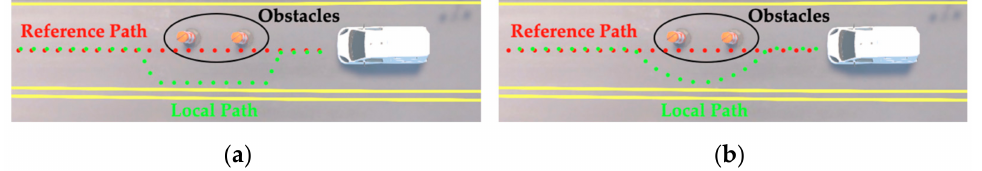
Figure 2. Problem of traditional local path planning; ( a ) the case in which the turning ratios of the vehicles are not considered and ( b ) the case in which the turning ratios of the vehicles are